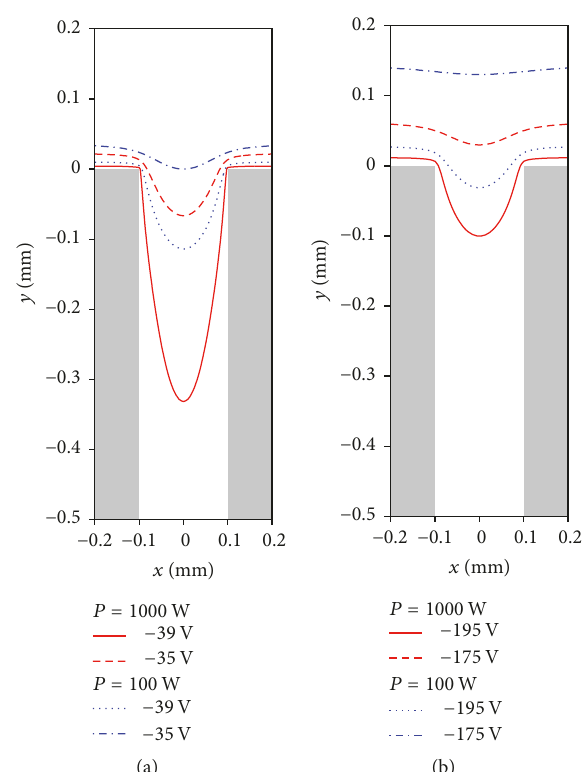
Figure 3: Penetration of sheath into the trench for different values of RF power and substrate bias. For each case two contours are plotted: 0.975 × 𝑈 0.875 × 𝑈 𝑈 = −40 V, (b) 𝑈 = −200 V. 𝑏 and 𝑏 . (a) 𝑏 𝑏